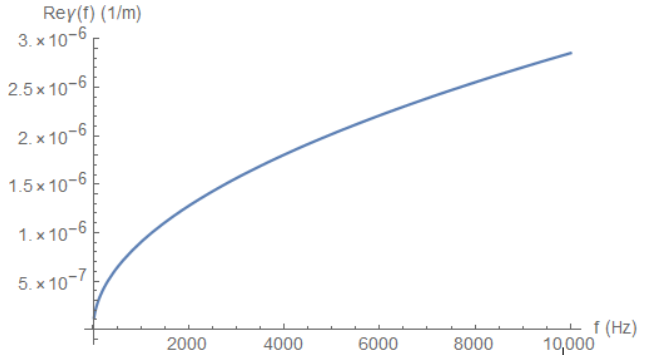
Figure 10. Re γ for high frequencies.